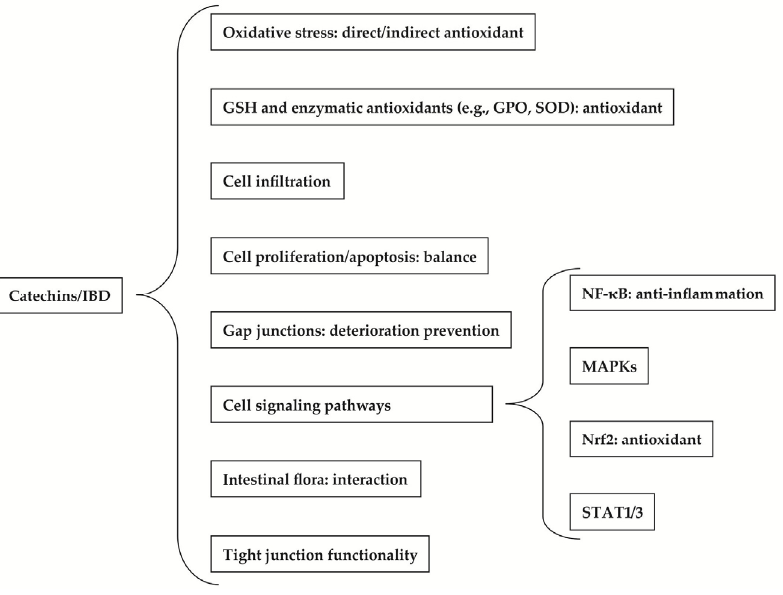
Figure 1. The main targets of action of catechins in IBD according to this article.